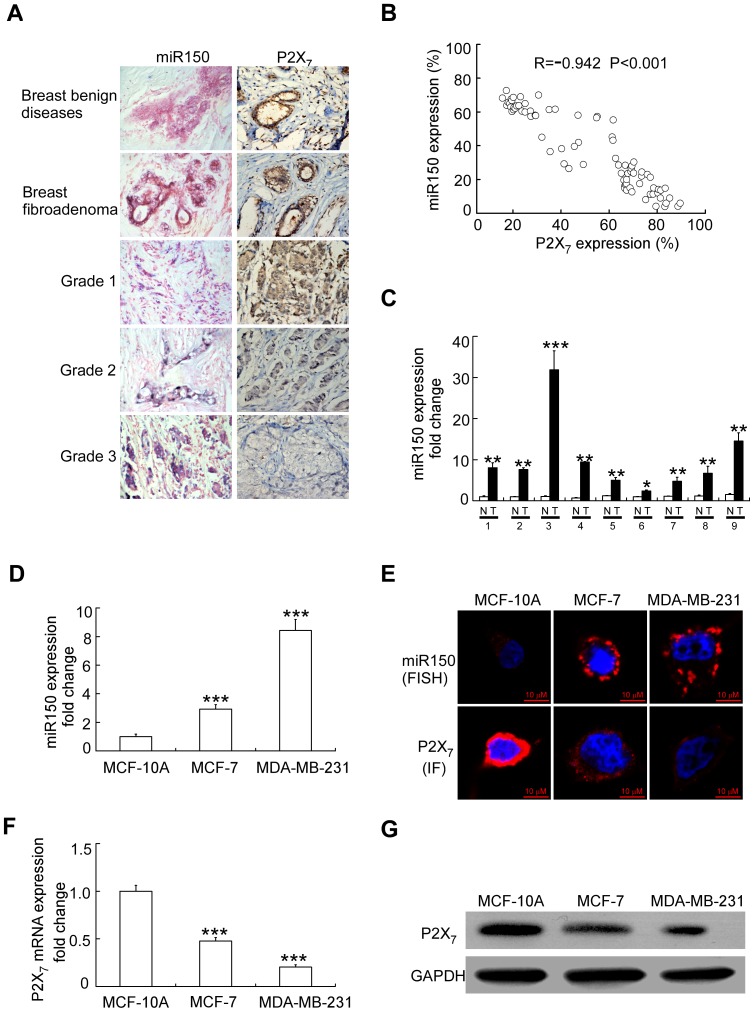
miR-150 levels correlate inversely with P2X7 in breast carcinomas and breast cancer cell lines.(A) Representative microscopic images (×400) of in situ hybridization (ISH) for miR-150 and immunohistochemistry for P2X7 receptor in breast tumors. (B) The correlation of miR-150 with P2X7 receptor protein expression in breast cancer. Pearson correlation coefficients (R) and P-values (p) are indicated. (C) Relative expression of miR-150 (normalized to U6) was detected by using a qRT-PCR in breast tumor tissue sample and matched adjacent non-tumor tissue sample. * p<0.01; ** p<0.01; *** p<0.001, Student's t-test for tumor compared to matched adjacent non-tumor tissue. T, tumor; N, matched adjacent non-tumor tissue. (D) Relative expression of miR-150 (normalized to U6) are using a qRT-PCR in the corresponding breast cancer cell lines (MCF-7 or MDA-MB-231) and human mammary epithelial cell lines (MCF-10A). ***; p<0.001, Student's t-test for MCF-7 or MDA-MB-231 cells compared to MCF-10A cells or MDA-MB-231 cells compared to MCF-7 cells. (E) Microscopic images (×400) of relative expression of miR-150 (FISH) and P2X7 receptor (immunofluorescence, IF) in breast cancer cell lines. (F) qRT-PCR data of P2X7 mRNA (normalized to GAPDH mRNA) in breast cancer cell lines. ***; p<0.001, Student's t-test for MCF-7 or MDA-MB-231 cells compared to MCF-10A cells or MDA-MB-231 cells compared to MCF-7 cells (G) Western-blotting analysis of the P2X7 receptor expression in breast cancer cell lines. Data are the mean of three determinations and shown is representative of three experiments that gave similar results.